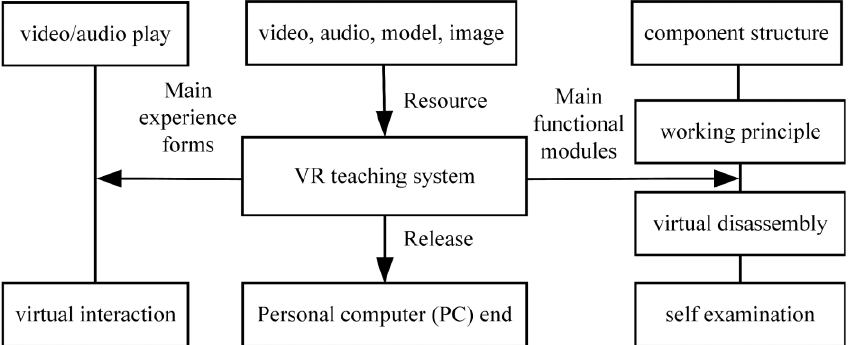
Figure 1. Block diagram of the teaching system based on VR technology.